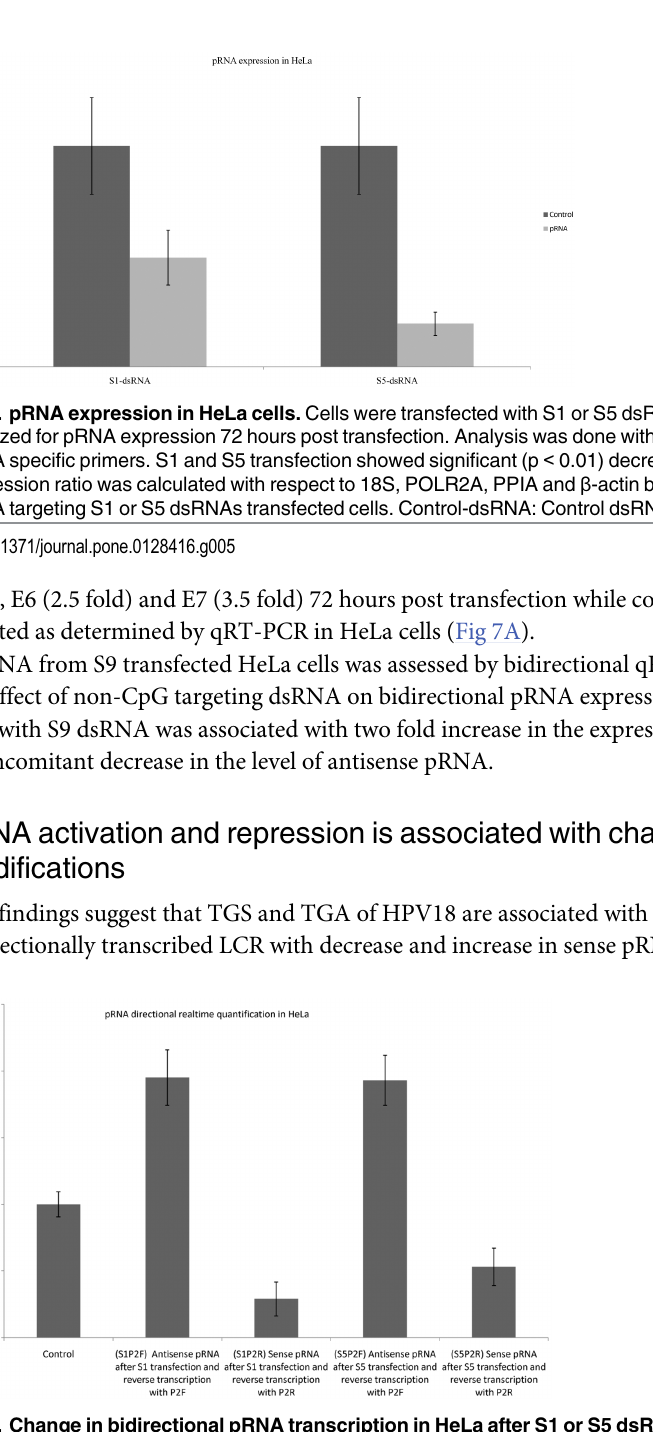
Fig 6. Change in bidirectional pRNA transcription in HeLa after S1 or S5 dsRNA transfection. The levels of sense and antisense pRNAs were checked using directional qRT-PCR using P2 primer. Fold changes in sense and antisense pRNA expression were calculated using delta-delta-Ct method with respect to 18S as internal Control. Control: Control dsRNA treated cells, S1P2F: cells transfected with S1 dsRNA followed by RNA isolation and reverse transcription with P2F primer, S1P2R: cells transfected with S1 dsRNA and RNA isolated was reverse transcribed with P2R primer, S5P2F: cells transfected with S5 dsRNA and RNA isolated was reverse transcribed with P2F primer, S5P2R: cells transfected with S5 dsRNA and RNA isolated was reverse transcribed with P2R